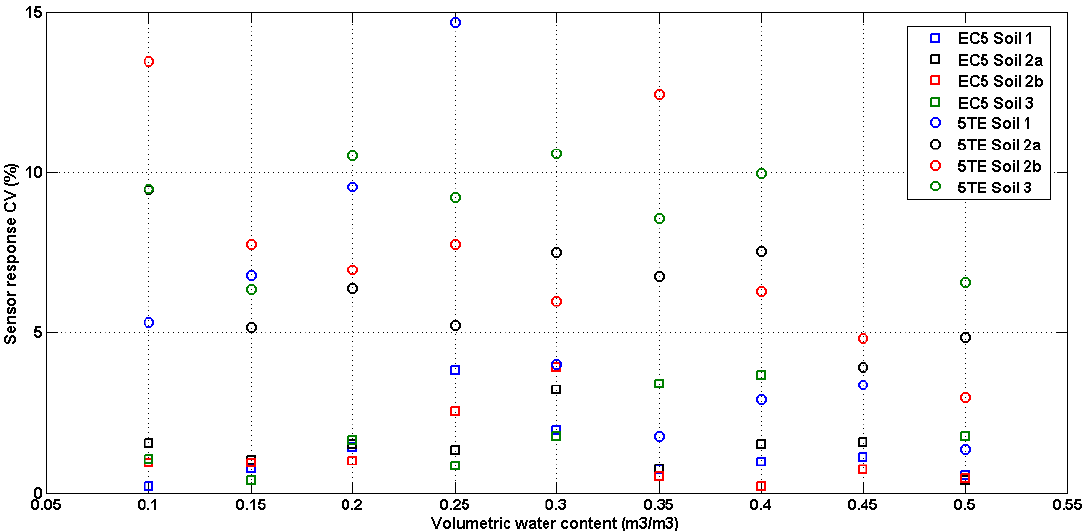
Figure 4. Scatter plot of the coefficient of variation (n = 3) of the volumetric water content measurement for two sensors, at different volumetric water content and in different soil texture. Results presented were obtained during the standard calibration method.